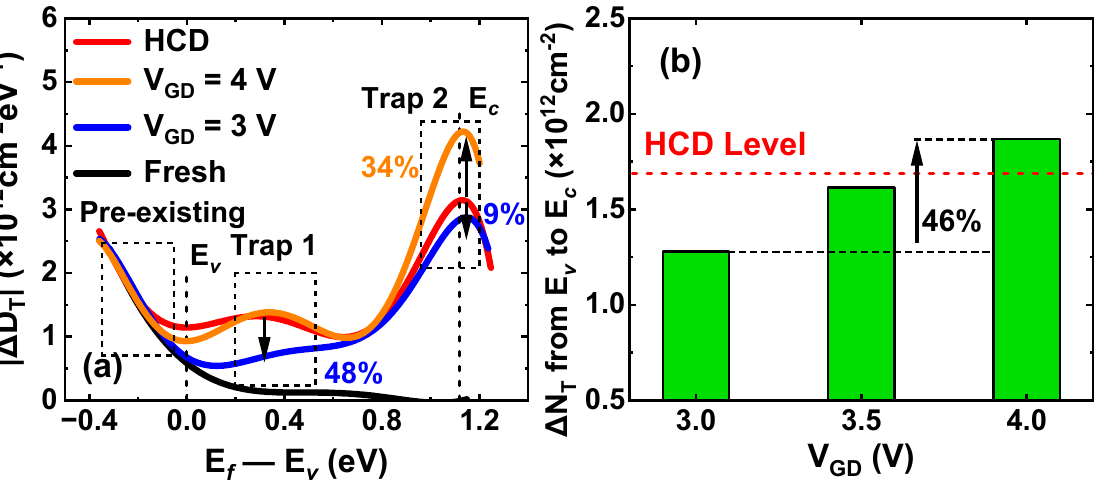
Figure 10. ( a ) Extracted energy distribution of ∆ D T in the new round of HCD stress after repairing by different GIDL biases. “Fresh” is ∆ D HT extracted by multi-DMP method separately. ( b ) Extracted ∆ N T from E v to E c in the new round of HCD stress. Fixed V D,GIDL = − 2.5 V; V G,GIDL varies from 0.5 V to 1.5 V.